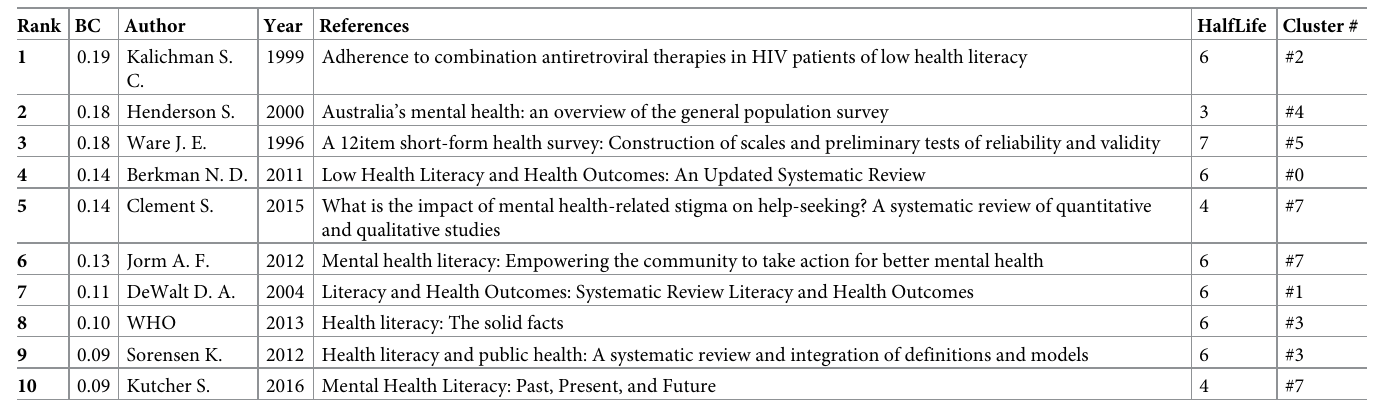
Table 5. Top 10 reference with the highest BC of health